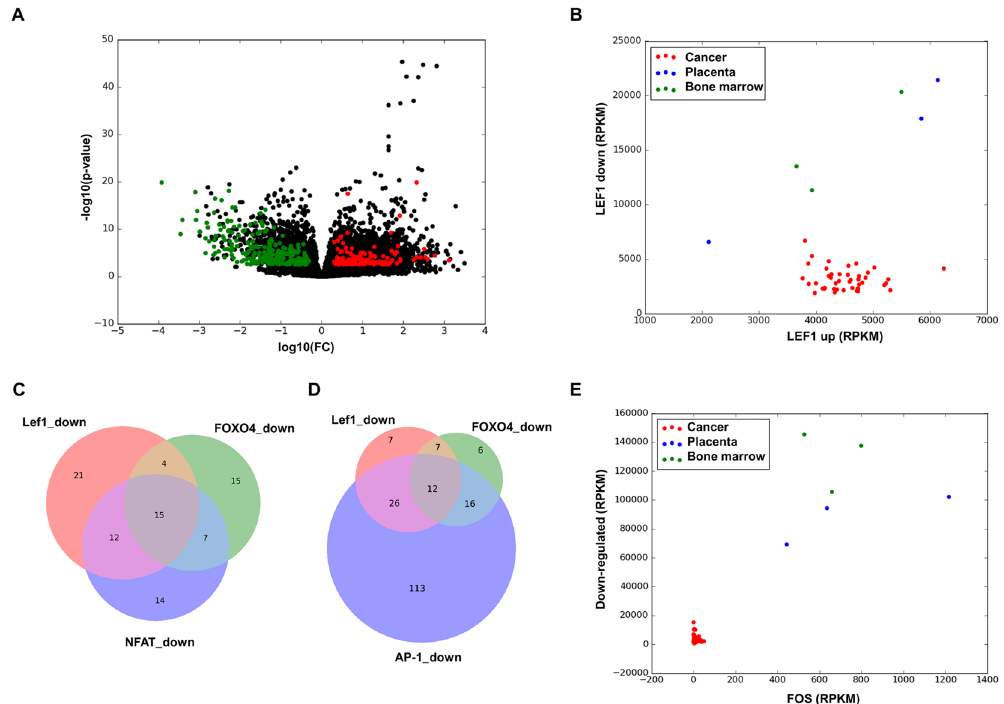
Figure 4. Volcano plot resulting from the differential expression analysis between cancer cell lines and mesenchymal stem cells. Genes found also to be differentially expressed in the microarray analysis are shown in red (up-regulated) and green (down-regulated) ( A ). Plot showing the sums of expression levels of genes regulated by LEF1 ( B ). Overlap between the consensus down-regulated genes controlled by LEF1, FOXO4, and NFAT ( C ). Overlap between the consensus down-regulated genes controlled by LEF1, FOXO4, and AP-1 ( D ). Plot showing the sum of expressions of all the down-regulated consensus genes versus the FOS gene ( E